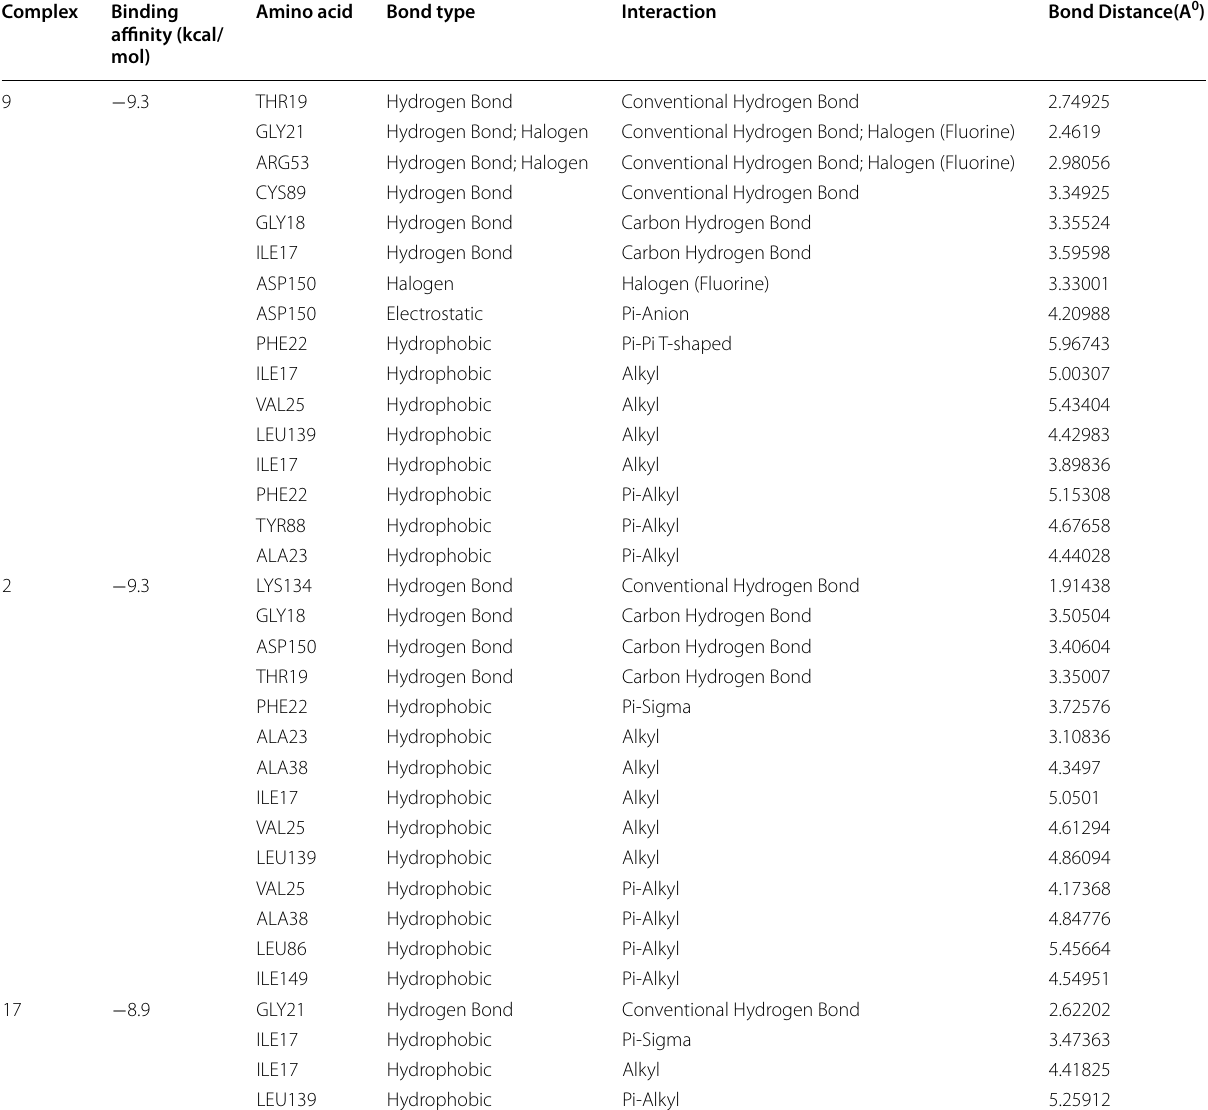
Table 12 Binding affinity, interaction type, bond type and distances in some complexes Complex Binding affinity